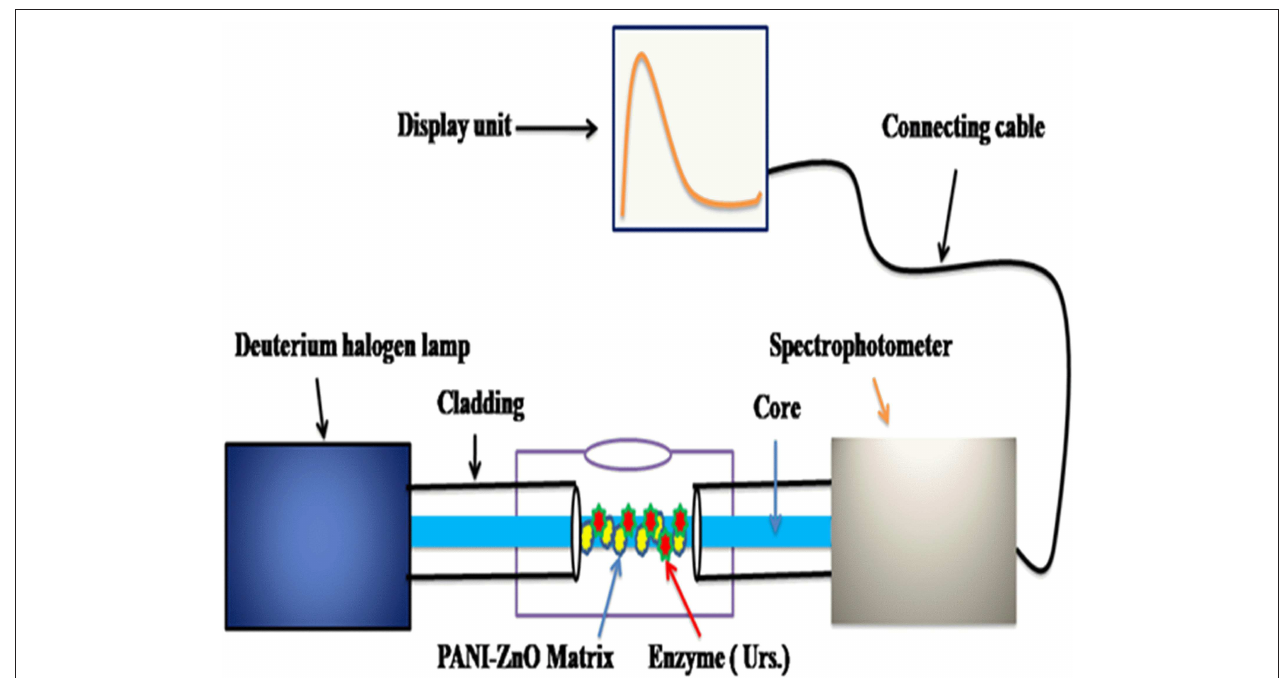
FIGURE 1 | Experimental set-up.